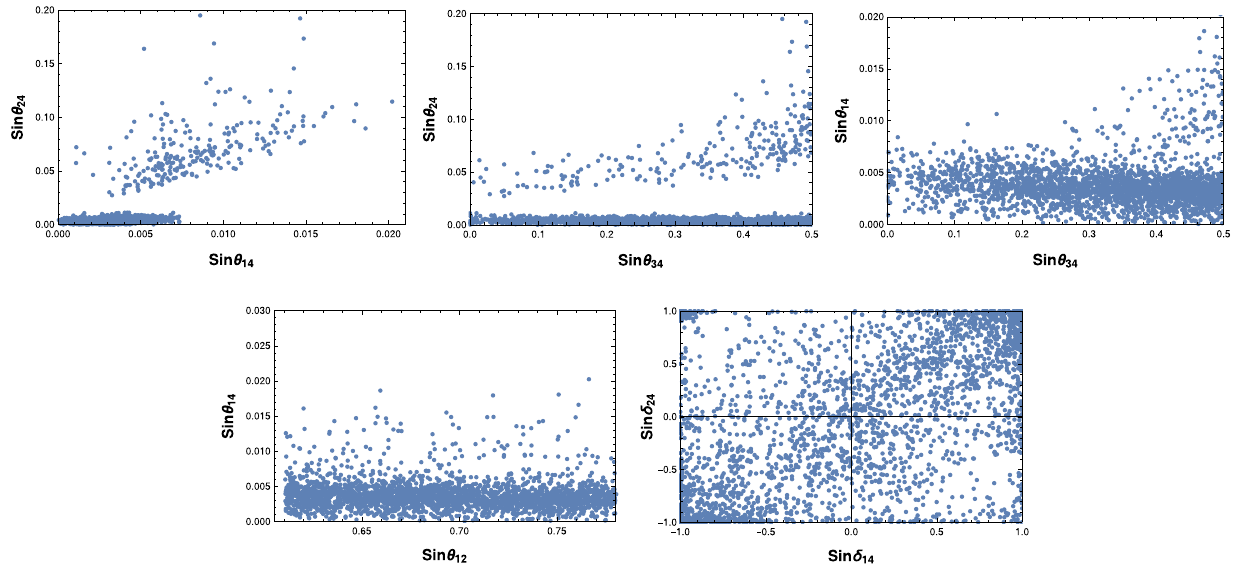
Fig. 6 Neutrino oscillation parameters in active-sterile sector for case (i) from texture 2 zero category for